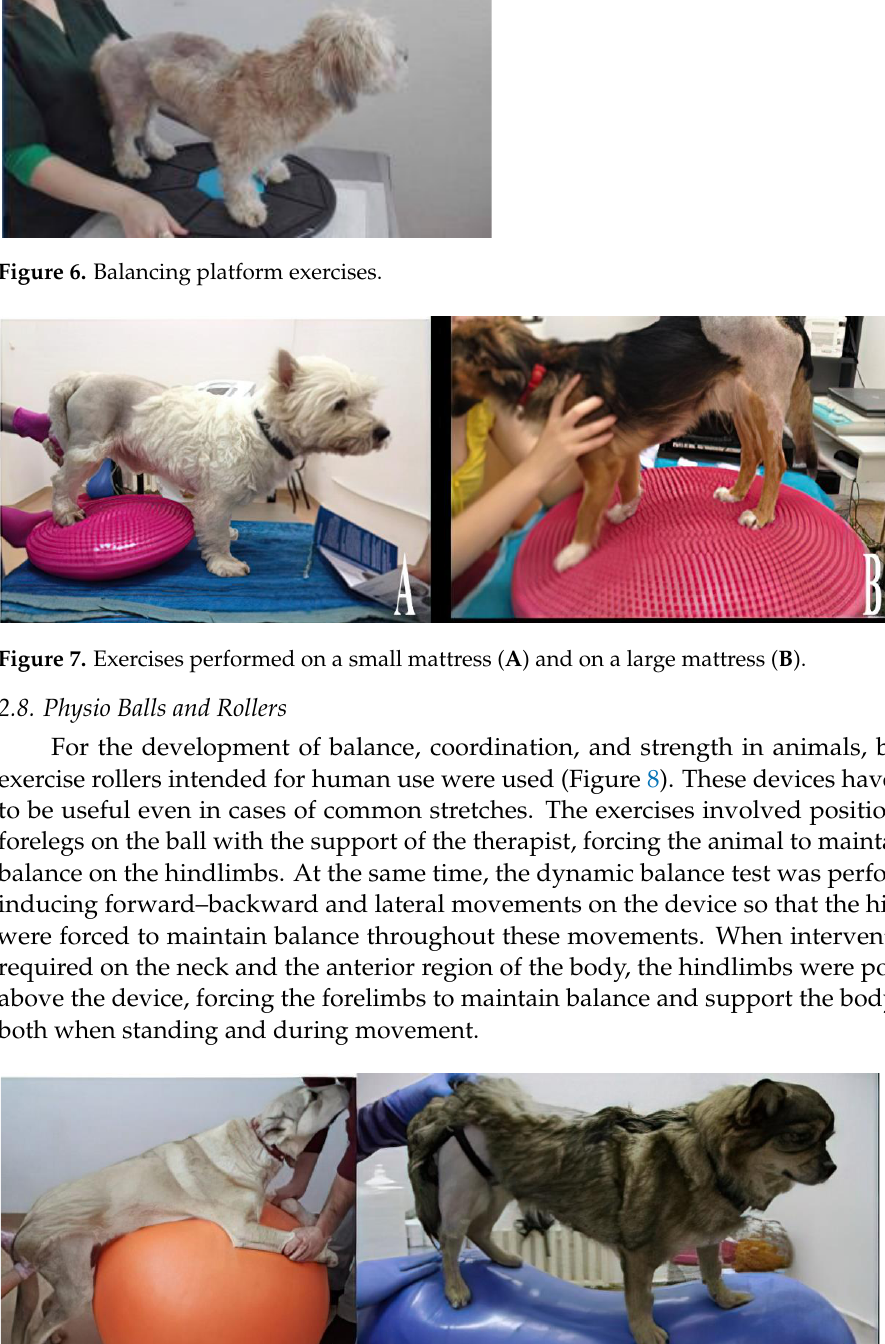
Figure 5. Changing the center of gravity forces the animal to adapt its center of gravity.